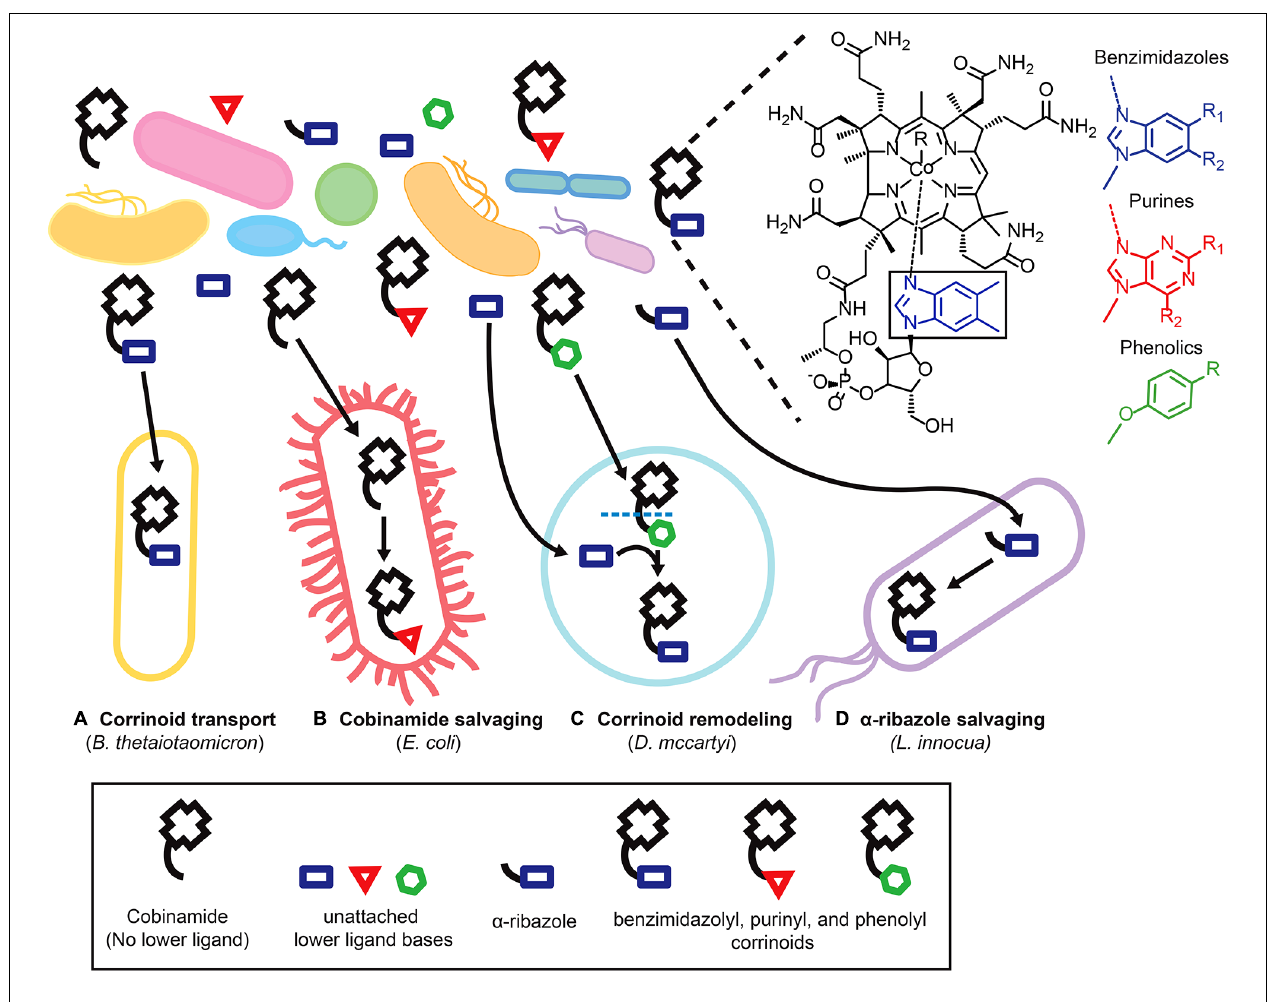
classes of lower ligand bases of other corrinoids. Specific strategies for obtaining corrinoids are illustrated with representative bacteria listed in parentheses. (A) Corrinoid transport in Bacteroides thetaiotaomicron . (B) Cobinamide salvaging in Escherichia coli . (C) Corrinoid remodeling in Dehalococcoides mccartyi . (D) α -ribazole salvaging in Listeria innocua .